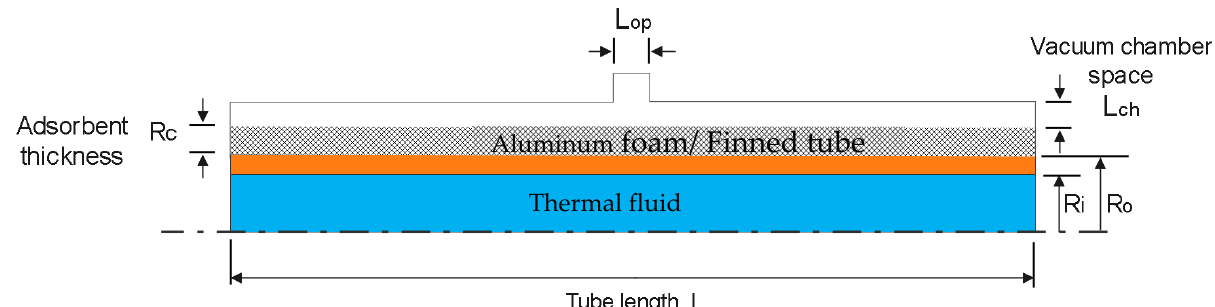
Figure 2. The 2 ‐ D axisymmetric model of the four investigated domains . Figure 2. The 2-D axisymmetric model of the four investigated